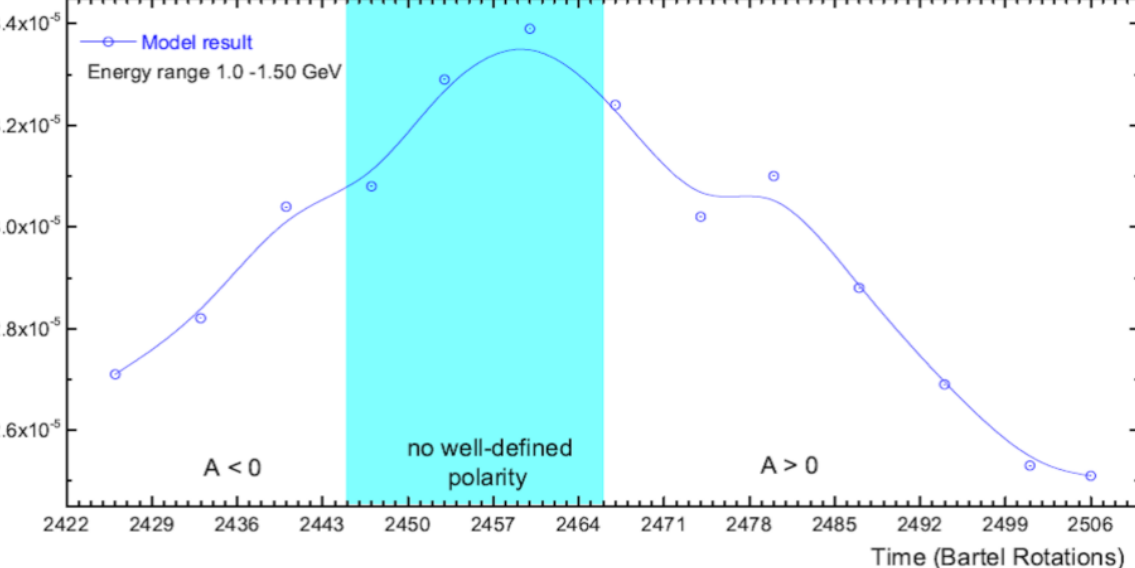
Figure 20. Similar to Figure 19, now enlarged and not normalized, showing the computed anti-proton to proton ratio for Bartels rotation numbers 2426–2506 (May 2011–May 2017), here for KE of 1.0–1.5 GeV. Circled points indicate model results, interpolated and smoothed as indicated by the solid